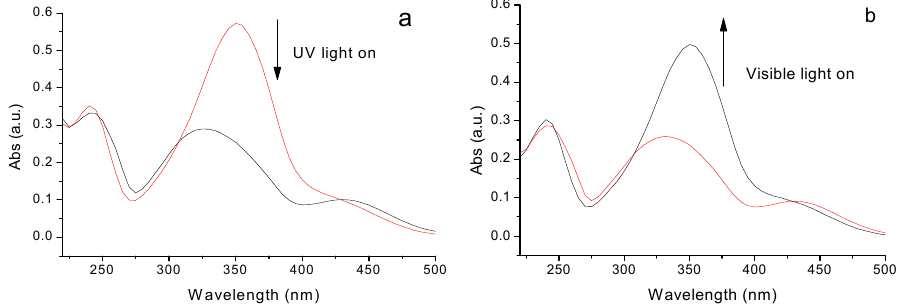
Figure 7. D-Azo-D 230 in water at 20 °C (0.002 wt%): ( a ) change in absorption of UV-Vis spectra over time under UV light (365 nm, 3.8 mW/cm 2 ); ( b ) change in absorption of UV-Vis spectra over time under visible light (12.1 mW/cm 2 ).